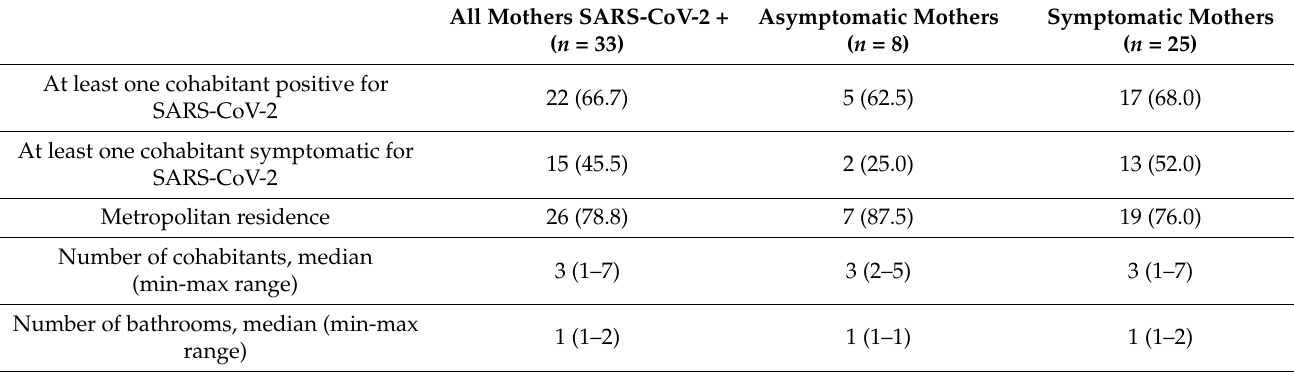
Table 4. Indoor environments and protective equipment used at home by caregivers of neonates born to SARS-CoV-2 positive